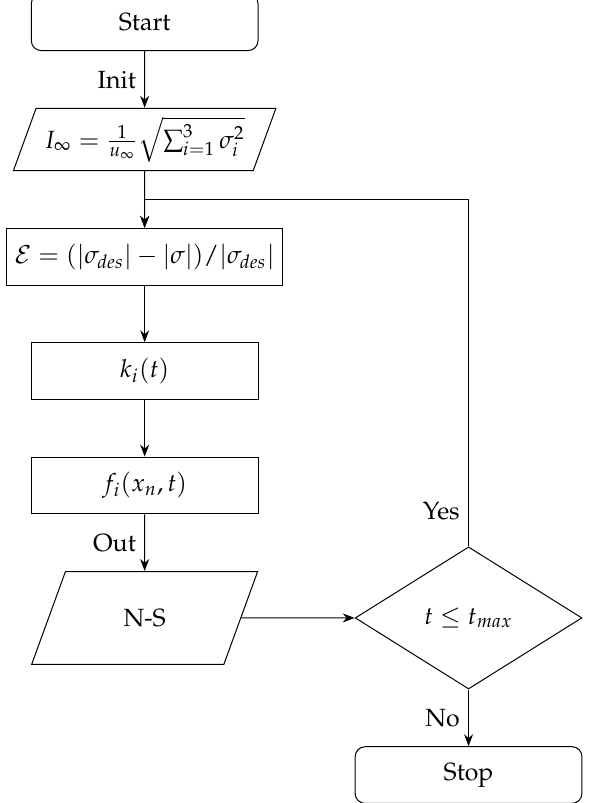
Figure 4. Iterative turbulence intensity control